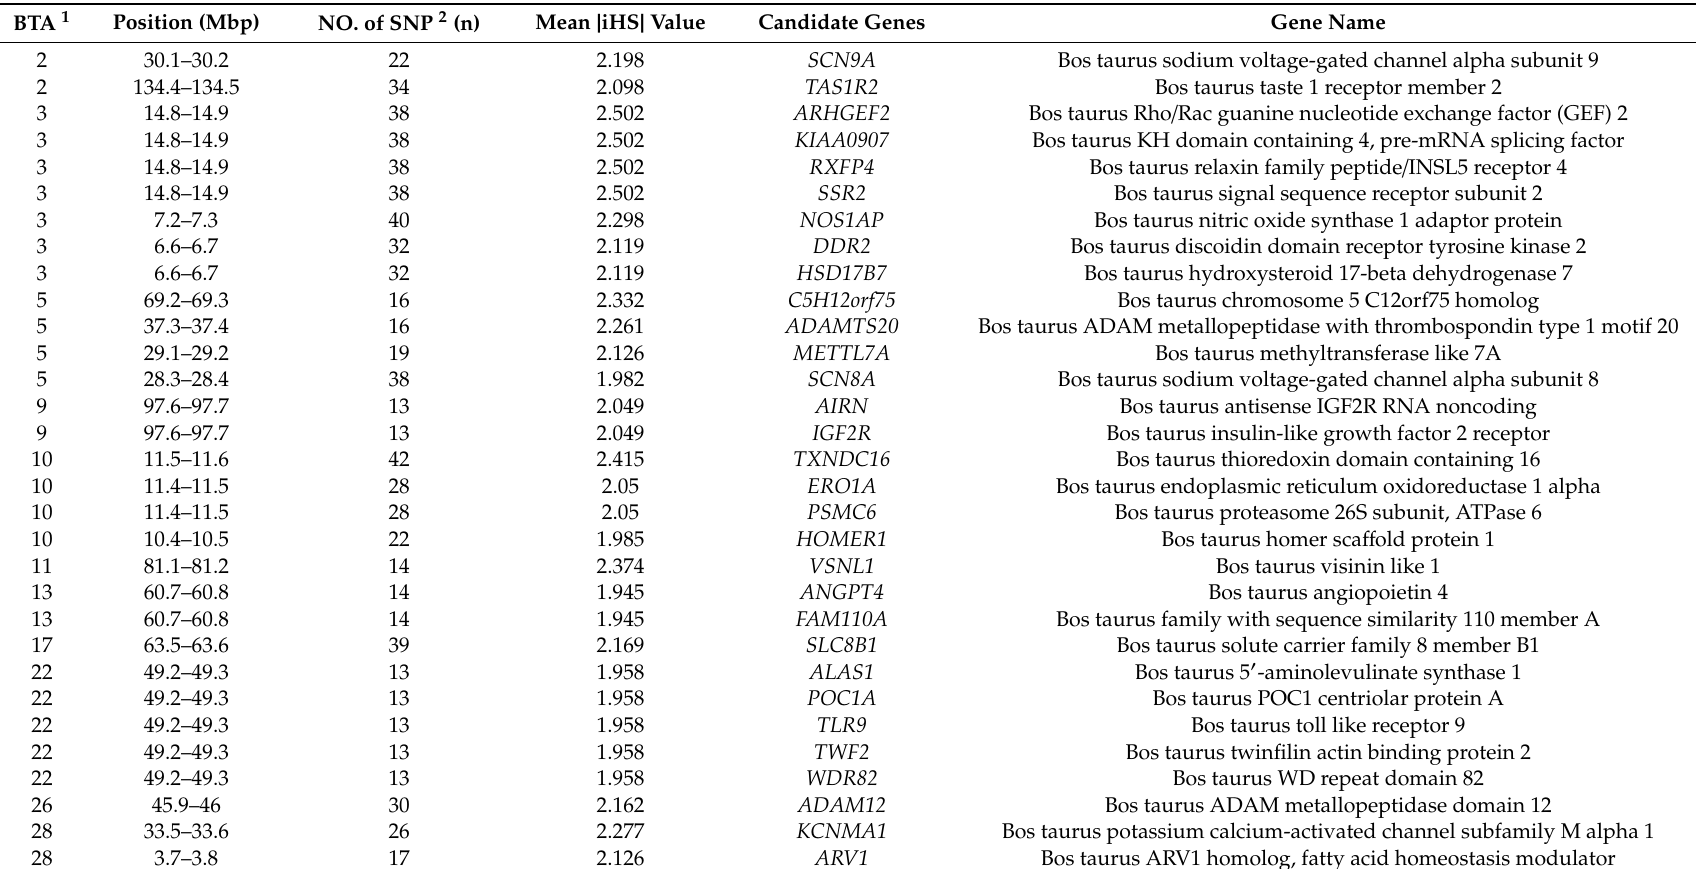
Table 1. Genomic region and associated genes of the top 20 significant | iHS | 3